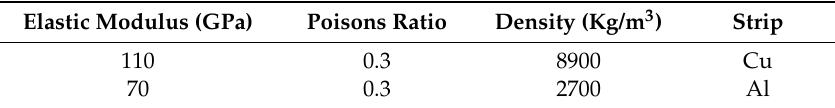
Table 1. Physical and mechanical properties of Cu and Al strips.